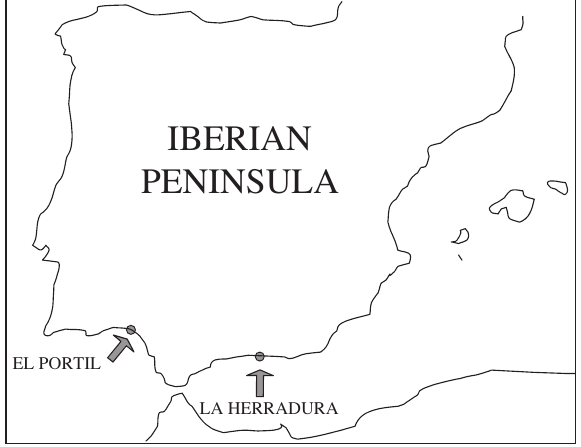
F IG . 1. – Map of Spain showing the sampling